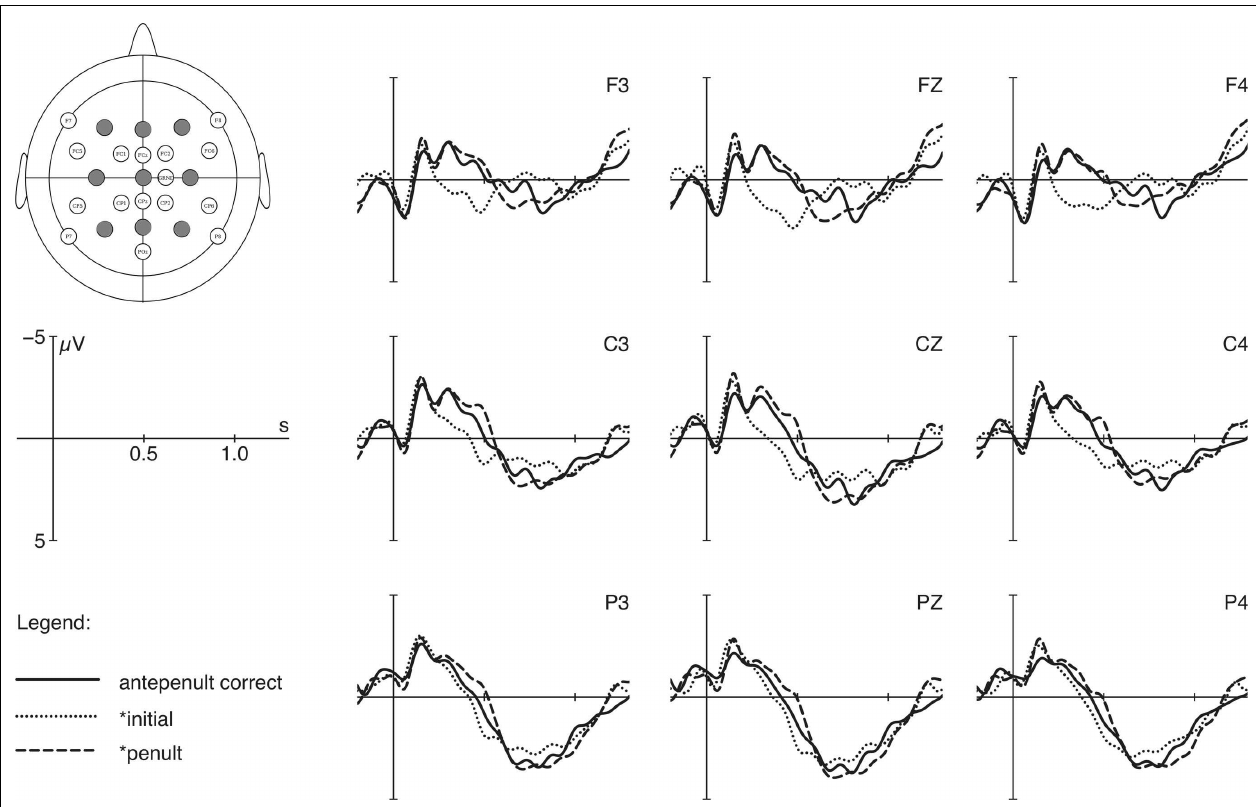
FIGURE 4 | EEG plots for stimuli with correct antepenultimate stress (solid line) and with shifts to initial syllable (dotted line) and to penultimate syllable (dashed line). Time from target onset is plotted on the x -axis, and amplitude is plotted on the y -axis (negativity upwards).